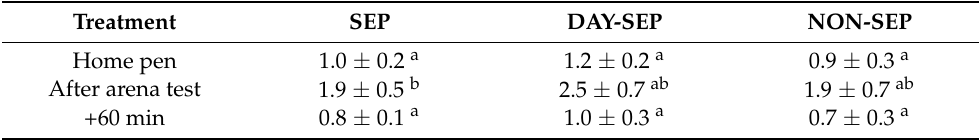
periods and within treatments between periods; p ≤